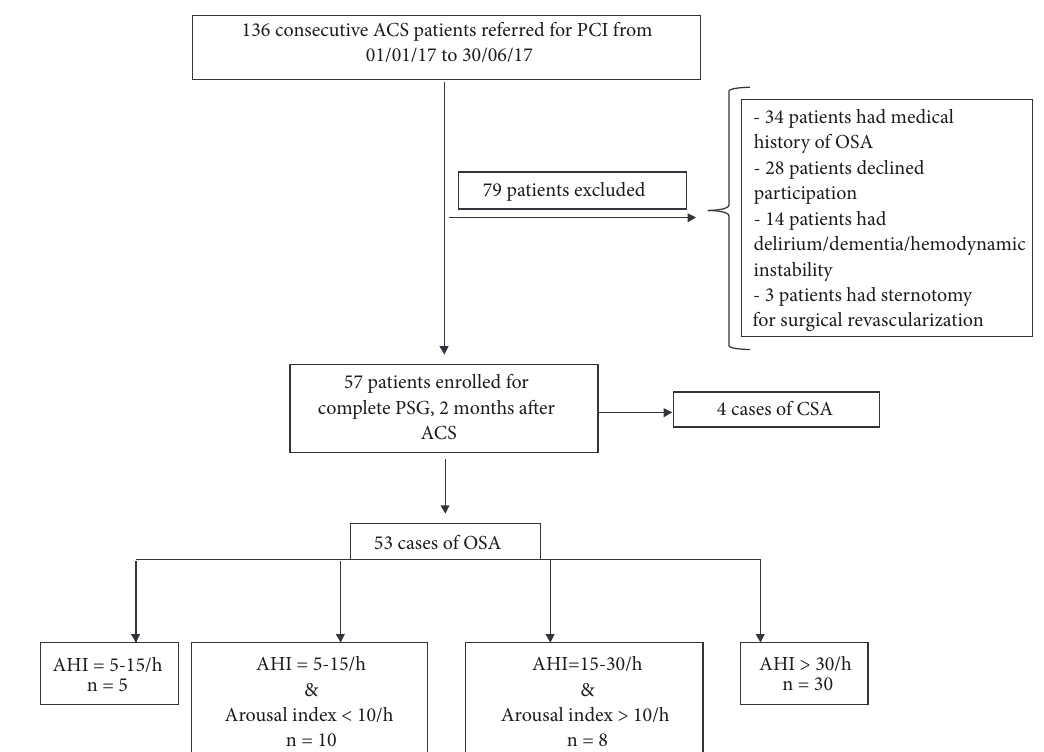
Figure 1: Flowchart: ACS: acute cardiac syndrome; CSA: central sleep apnea; OSA: obstructive sleep apnea; PCI: percutaneous coronary intervention; AHI: apnea-hypopnea index; PSG: polysomnography.